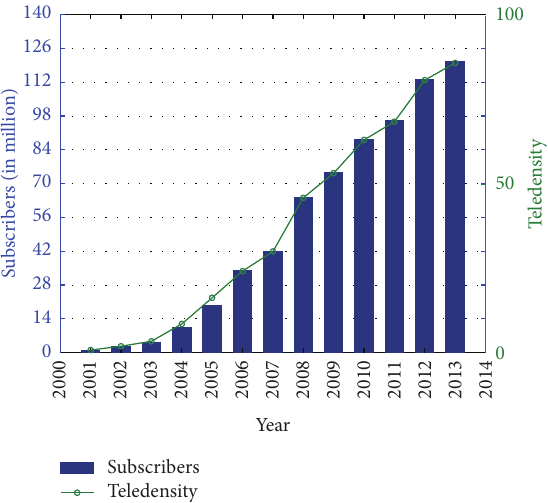
Figure 1: Trend of subscribers’ base and teledensity in the period (2001–June 2013) in Nigeria [15].